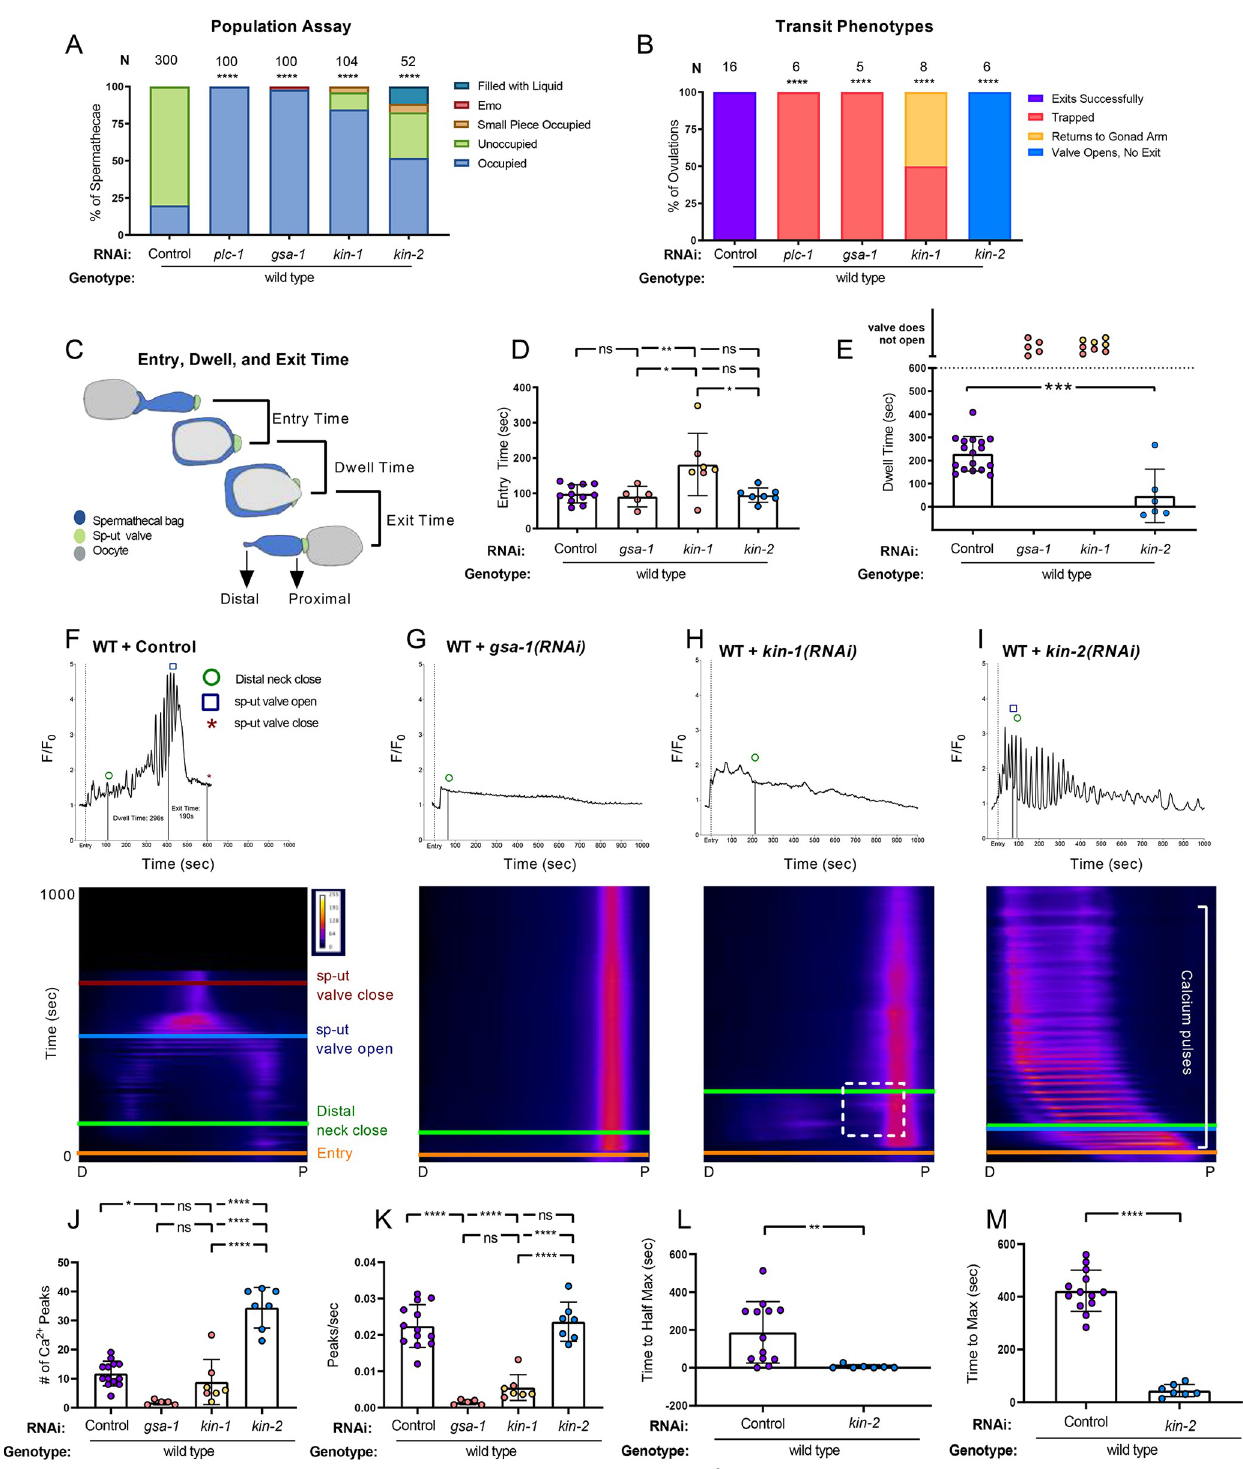
Fig 1. GSA-1/G α s and KIN-1/PKA-C, and KIN-2/PKA-R regulate contractility and Ca 2+ dynamics in the spermatheca. (A) Population assay of wild type animals grown on control RNAi, plc-1(RNAi) , gsa-1(RNAi) , kin-1(RNAi) , and kin-2(RNAi) . Spermathecae were scored for the presence or absence of an embryo (occupied or unoccupied), presence of a fragment of an embryo or presence of liquid (small piece occupied, filled with liquid), or the presence of endomitotic oocytes in the gonad arm (emo). The total number of unoccupied spermatheca were compared to the sum of all other phenotypes using the Fisher’s exact t -test. N is the total number of spermathecae counted. (B) Transit phenotypes of the ovulations of wild type animals treated with control RNAi,